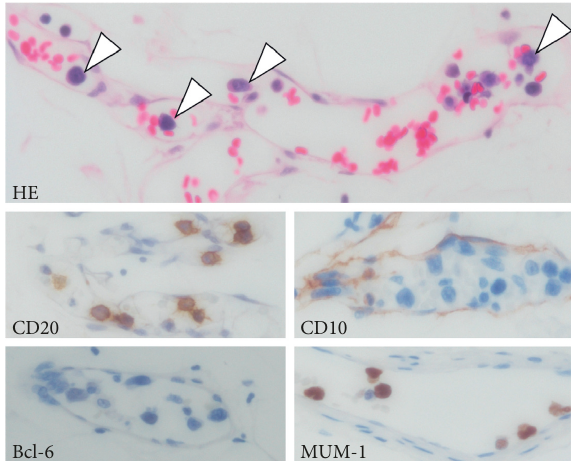
Figure 2: Histopathology of the angiolipoma. Large atypical lym- phocytes in the lumina of the capillaries. Lymphoma cells are in- dicated by arrowheads. They are CD20(+), CD10( − ), Bcl-6( − ), and MUM-1(+). Magnification, × 400. HE, hematoxylin and eosin